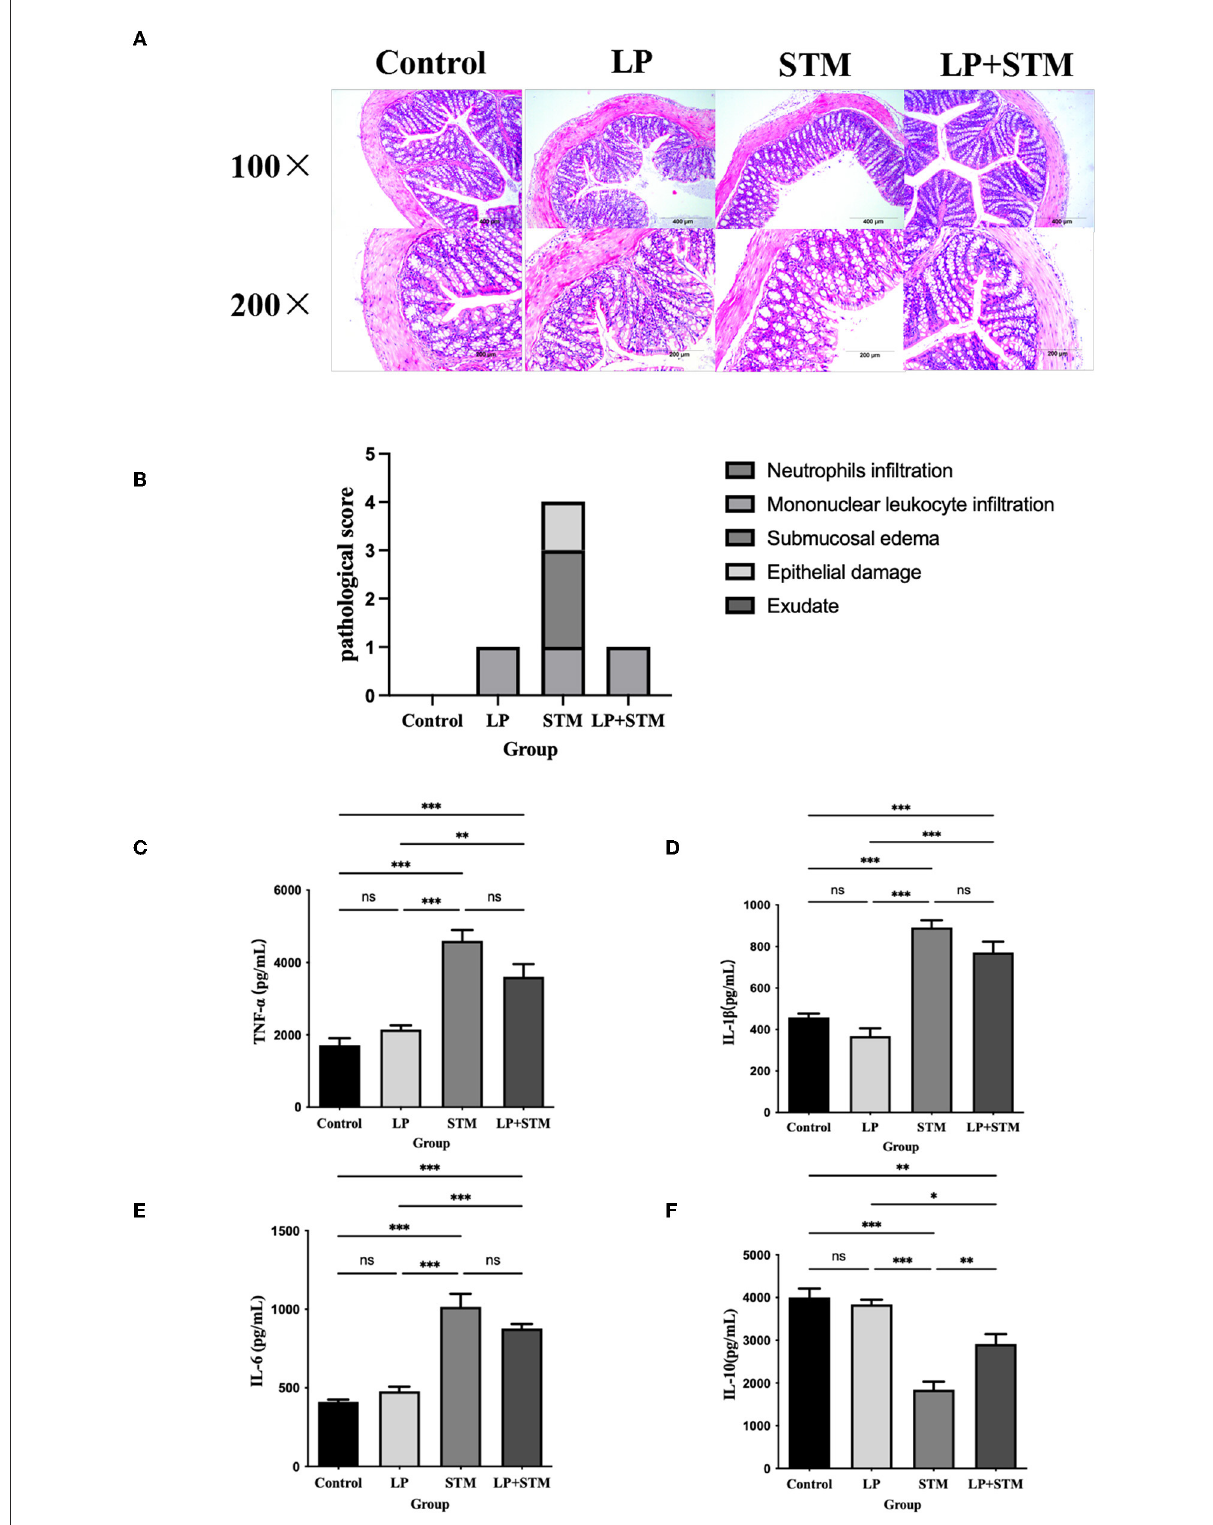
FIGURE7 LP alleviated the intestinal inflammatory injury induced by STM in mice. (A) The mice colon was performed by H&E (100 × , 200 × ) staining, to detect the intestinal pathological changes in each group of mice after STM infection. Scale bar: 400 µ m. (B) Histograms of pathological scores. (C–F) ELISA kits were used to detect the expression of cytokines (TNF- α , IL-6, IL-1 β and IL-10) secreted by the intestinal mucosa of mice in the control, LP, LP + STM and STM groups. Results are presented as means ± SD (Data were analyzed using one-way ANOVA. ns not significant, * p < 0.05, ** p < 0.01, *** p <